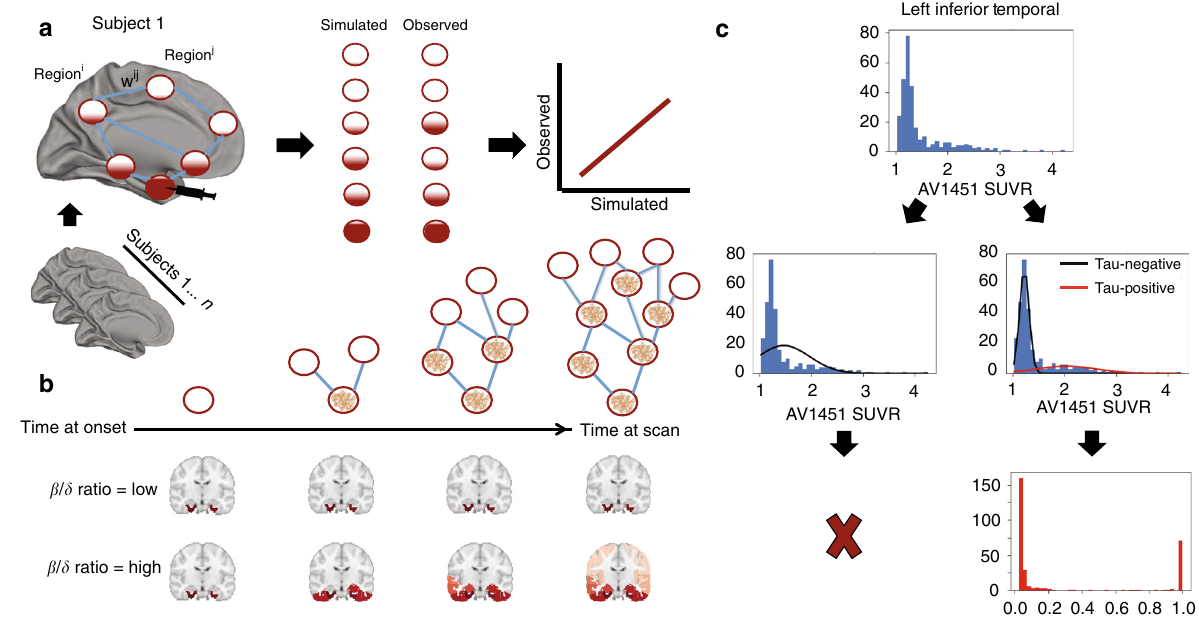
Fig. 1 Methodological approaches. a An arti fi cial system based on a pairwise relationship (e.g. functional connectivity) matrix is created, where the relationship between regions i and j is represented by weight ij . For each subject, a seed is placed at the model epicenter, and the diffusion of this signal over time is simulated through the system, where the inter-regional relationships determine the pattern of spread, and subject-level free parameters determine the velocity of diffusion, until an optimal fi t is reached. The simulated tau signal is then compared to the observed tau-PET signal to evaluate the model. b Advantages of the ESM over traditional approaches includes the initiation of secondary seeding events as the diffusion process reaches new regions (top), and the fi tting of subject-level production ( β ) and clearance ( δ ) parameters. A balance in these parameters will lead to little to no spreading over time, while increasing imbalance leads to accelerated spread. c The distribution of all SUVR values in the left inferior temporal ROI are shown. Two Gaussian mixture models are fi t to the data. When a one-component model fi ts the data better, the ROI is discarded. When a two-component model fi ts better, the probability that each values falls upon the second distribution is